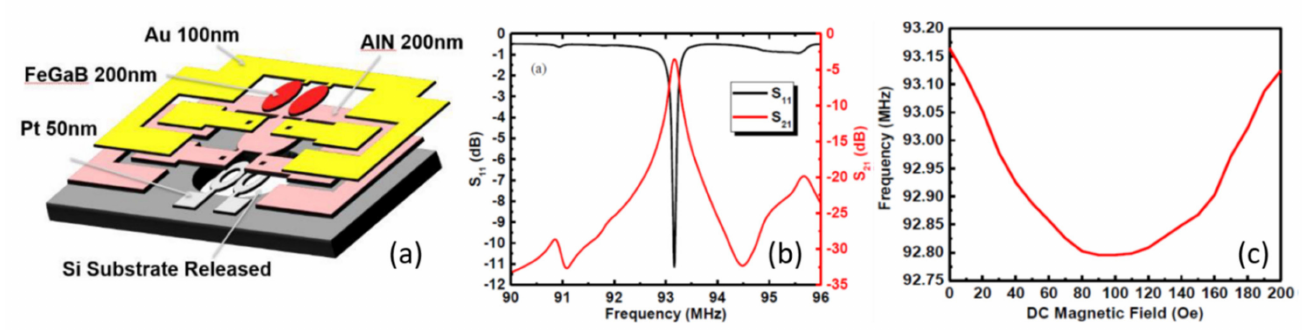
Figure 14. ( a ) Schematic of the layered structure of the NEMS ME band-pass filter. ( b ) Measured return loss S 11 and insertion loss S 21 at zero bias field. ( c ) Resonance frequency of as a function of DC magnetic fields. Reprinted with permission from ref. [55]. Copyright 2021 IEEE